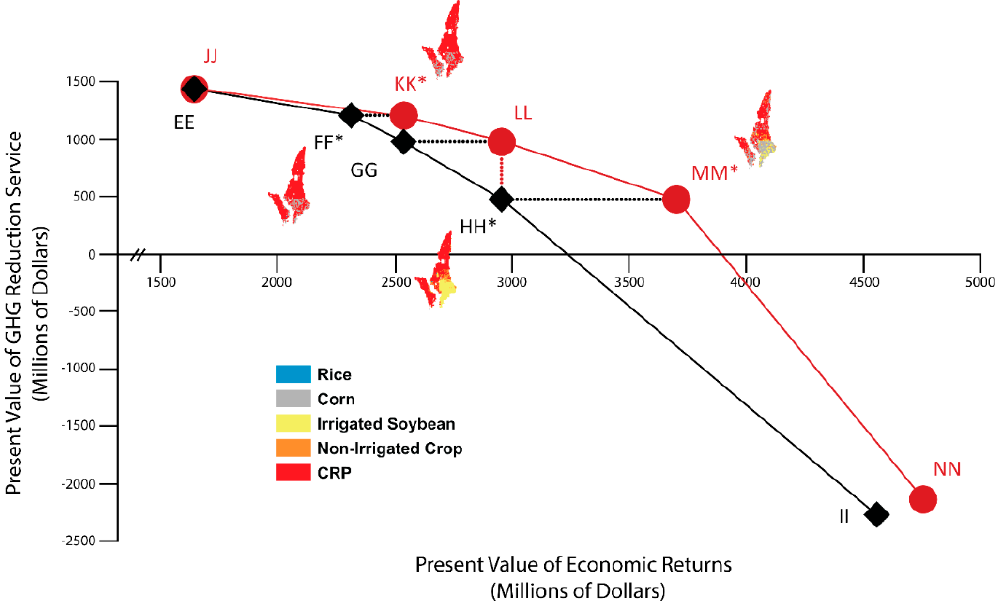
Figure 5. Crop mix patterns associated with specific points along the efficiency frontiers without